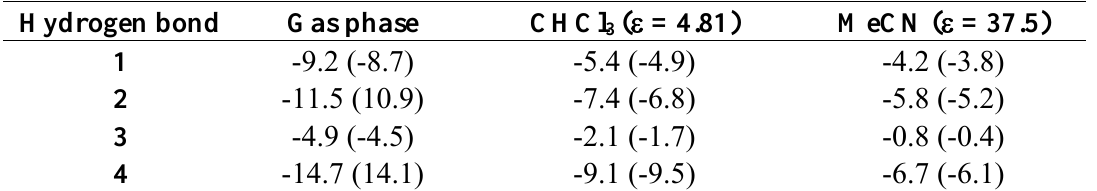
Table 4. Computed binding energies (in kcal/mol with and without BSSE correction) of all possible 1:1 complexes between nia and MAA in gas phase and in different polar surroundings.